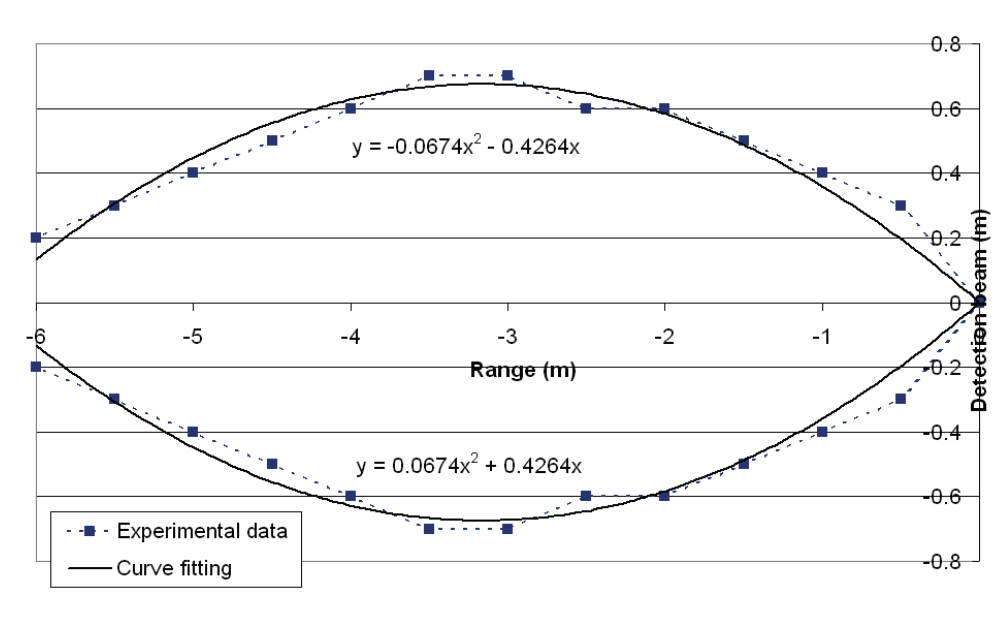
Figure 3. Experimental sensor